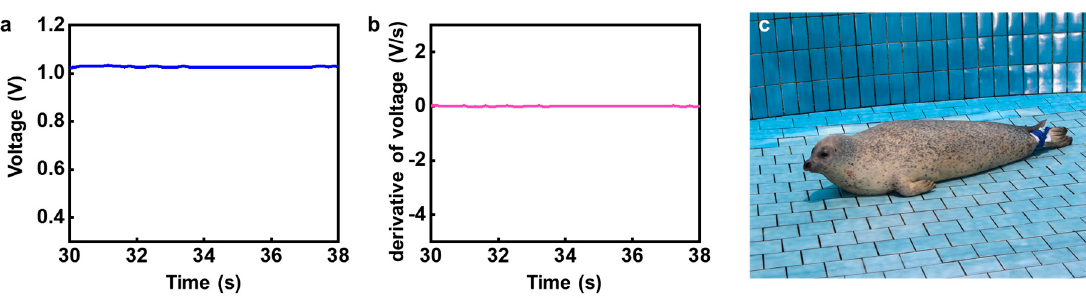
Figure 6. Electrical signals and optical images describing the behavior of a captive harbor seal (HS) in a stationary state: ( a ) output voltage of the pressure sensor and ( b ) its slope as a function of time; ( c ) representative image of the captive HS’s posture in a stationary state.